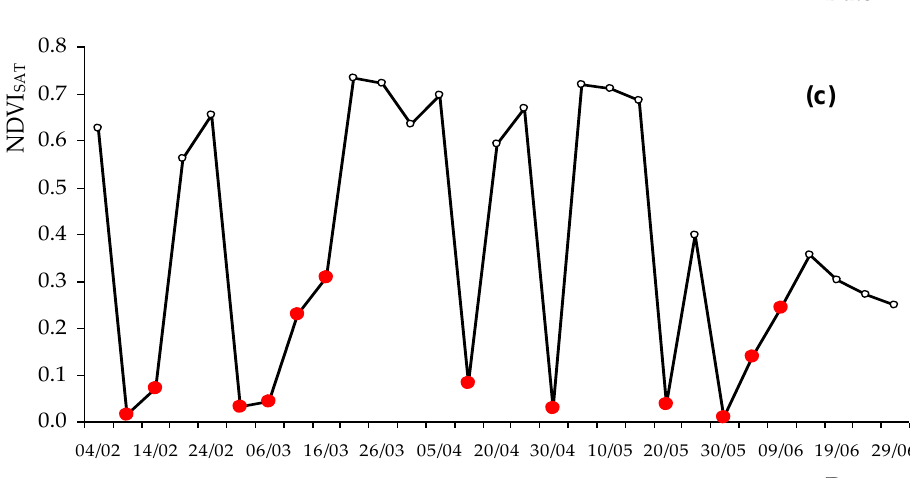
Figure 5. Reconstruction of historical vegetation index trends using time series records of satellite images (NDVI SAT ), retrieved between February and June 2016 ( a ), 2017 ( b ) and 2018 ( c ). Data are average values of the twelve sampling points. Red circles identify, in each year, the images affected by cloud cover over the study field. Note: Date format: Day/Month.